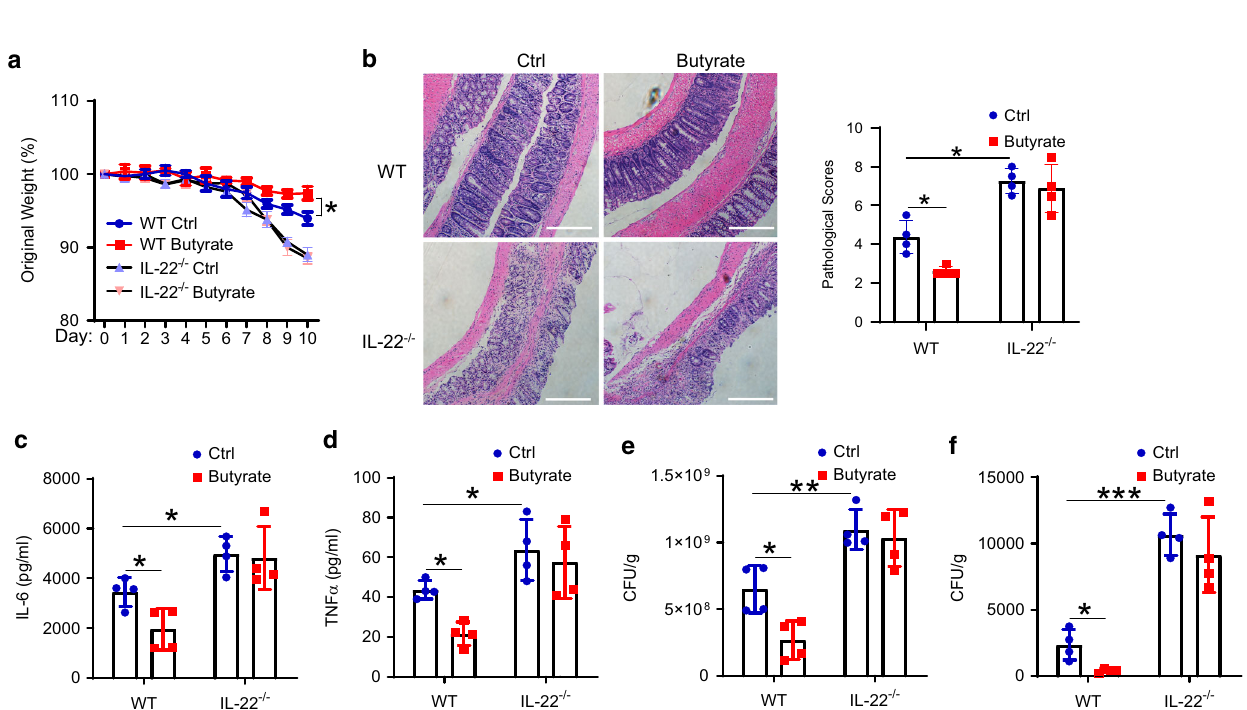
Fig. 8 Butyrate inhibits intestinal infection by promoting IL-22 production. WT and IL-22 − / − mice ( n = 4 mice/group) were orally infected with C. rodentium (5 × 10 8 CFU/mice) on day 0, and treated with or without butyrate (200 mM) in drinking water for 10 days. Mice were weighed daily ( a ). At day 10, colonic histopathology was analyzed ( b ), and colonic IL-6 ( c ) and TNF ( d ) production in colonic tissue was determined by ELISA. CFU in feces ( e ) and liver ( f ) were measured. One representative of three independent experiments was shown. Scale bar, 300 µ m ( b ). Data were expressed as mean ± SD. Statistical signi fi cance was tested by two-tailed unpaired Student t -test ( a , c – f ) or the nonparametric two-tailed Mann – Whitney U test ( b ). a * p = 0.0379; b * p = 0.0286; c * p = 0.0254 (WT butyrate vs WT control) and 0.0156 (IL-22 − / − control vs WT control); d * p = 0.00105 (WT butyrate vs WT control) and 0.0452 (IL-22 − / − control vs WT control); e * p = 0.0155, ** p = 0.0086; f , * p = 0.0163, *** p =